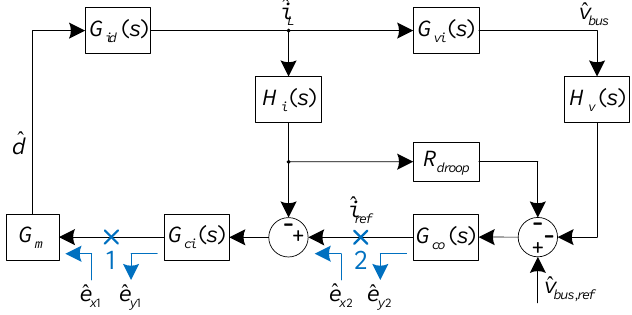
Figure 13. Measurement of the loop gains T 1 ( s ) and T 2 ( s ) .